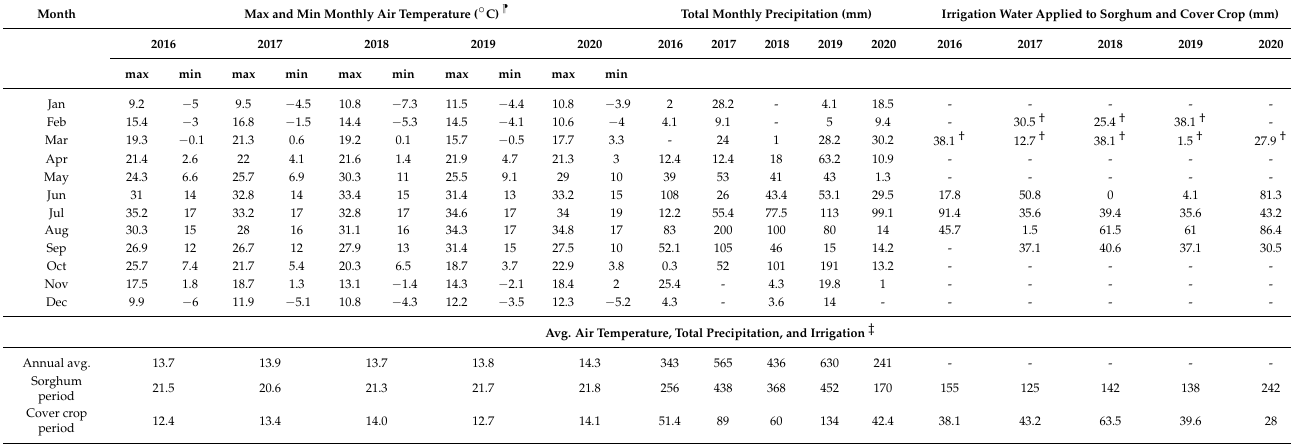
Table 1. Maximum and minimum monthly air temperature, total monthly precipitation, and irrigation water applied during sorghum and cover crop growing periods from 2016–2020. Month Max and Min Monthly Air Temperature (°C)